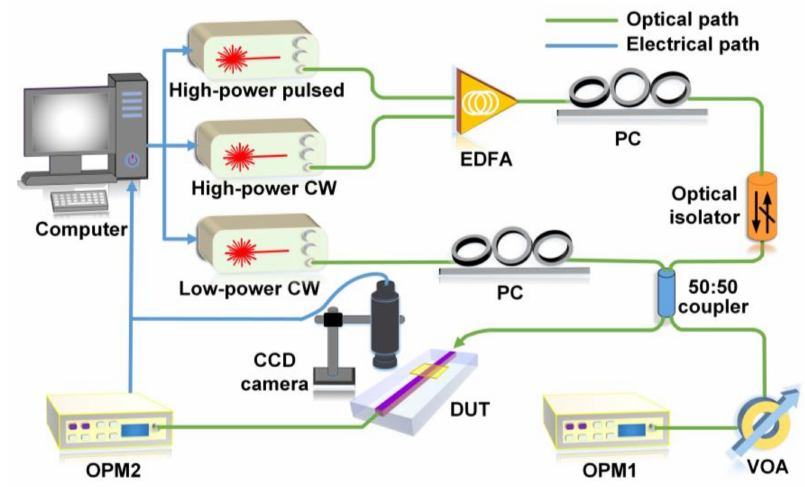
Figure 2. Experimental setup for characterization of PTT of GO-coated integrated waveguides. EDFA: erbium-doped fiber amplifier. PC: polarization controller. DUT: device under test. CCD: charged-coupled device. VOA: variable optical attenuator. OPM: optical power